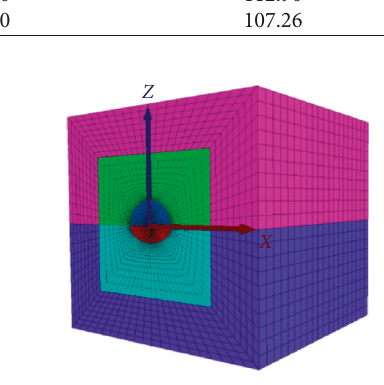
Figure 11: Model meshing. Table 2: Rock mass equivalent strength parameters under different dip angles ω .